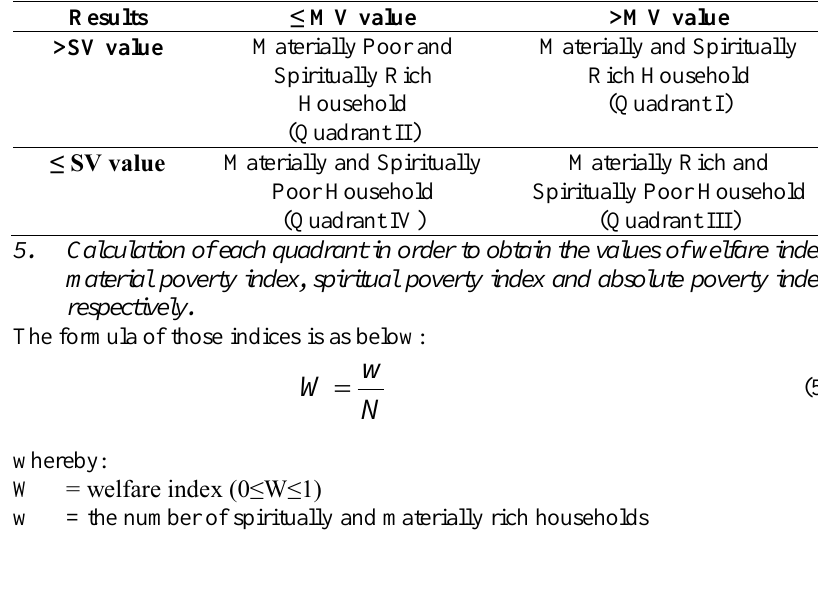
Table 2 Combination of MV and SV